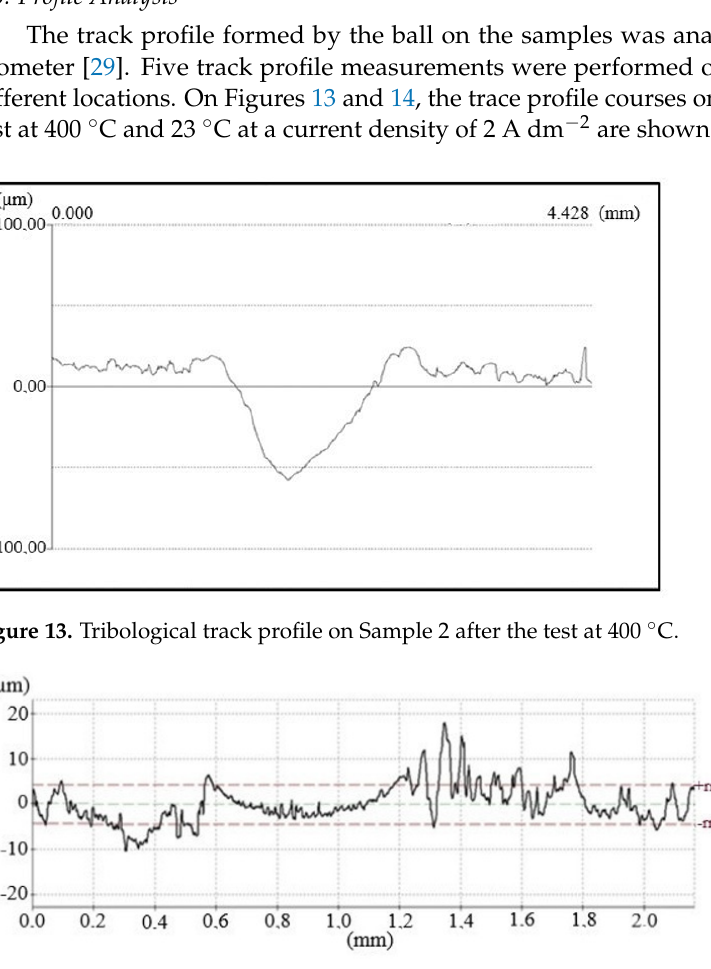
Figure 14. Tribological track profile on Sample 2 after the test at 23 °C. The track depth and width were measured. From the obtained data, the average examined parameter values were subsequently calculated and listed in Table 5. Table 5. Average parameters of track profiles on the samples after